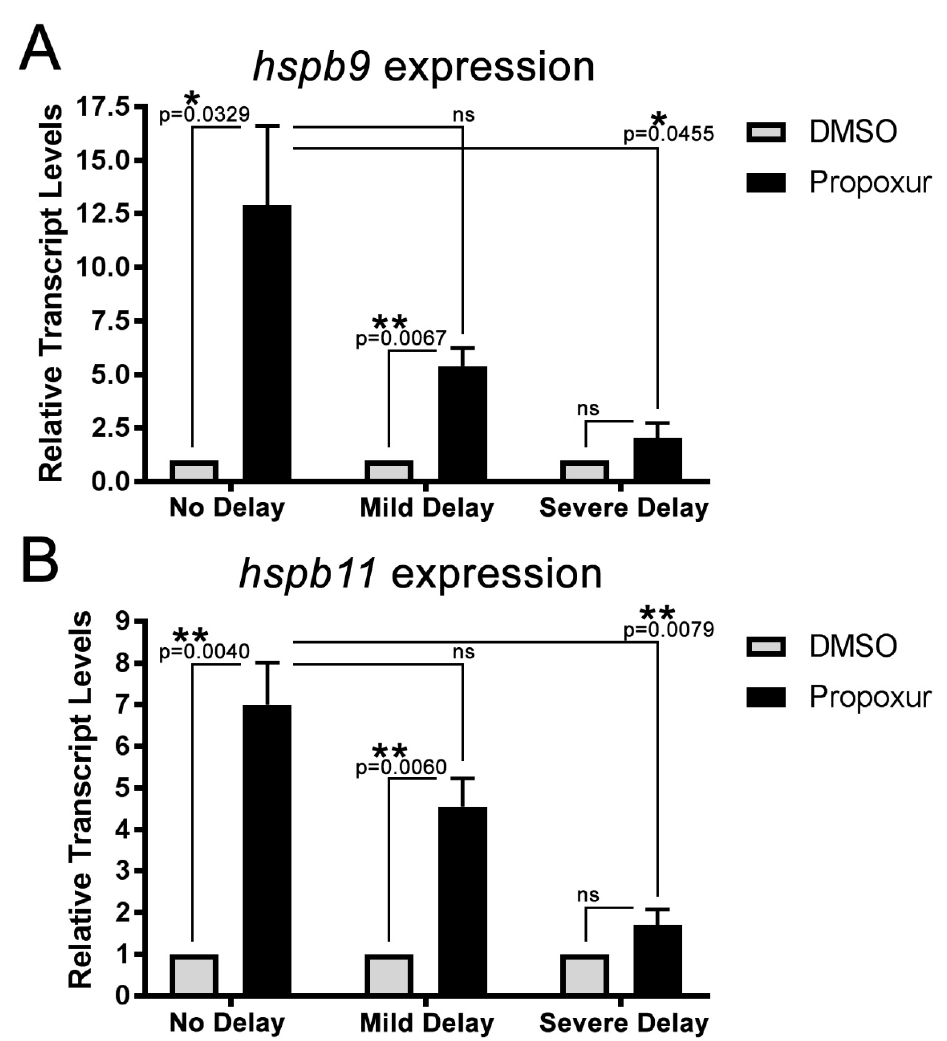
Figure 6. The expression of the small heat-shock proteins hspb9 and hspb11 correlates to the phenotypic outcome of propoxur exposure. ( A ) qRT-PCR of hspb9 expression in DMSO- or propoxur-treated embryos based on phenotype (no delay, mild delay, and severe delay) and ( B ) qRT-PCR of hspb11 expression in DMSO- or propoxur-treated embryos based on phenotype (no delay, mild delay, and severe delay): The asterisks represent different levels of significance ( p values are shown), and “ns” indicates no significance between the groups. The error bars represent SEM, and n = 3 per group.